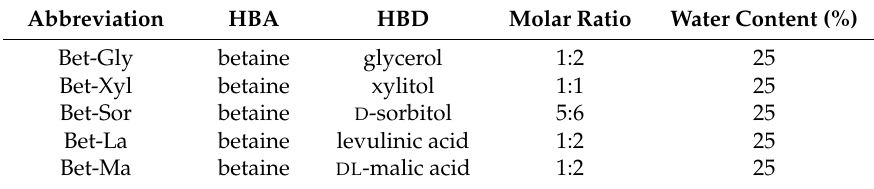
Table 2. 75% Bet-based DESs solutions tested for extraction.